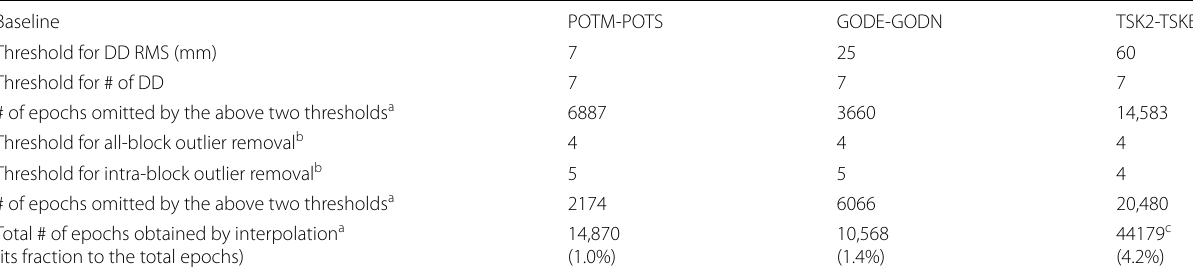
Table 2 Summary for data cleaning process after kinematic analysis